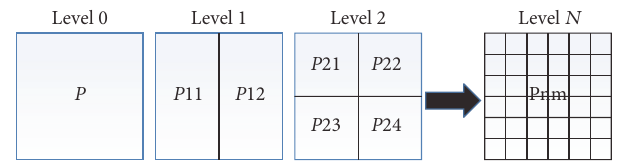
Figure 4: The method of